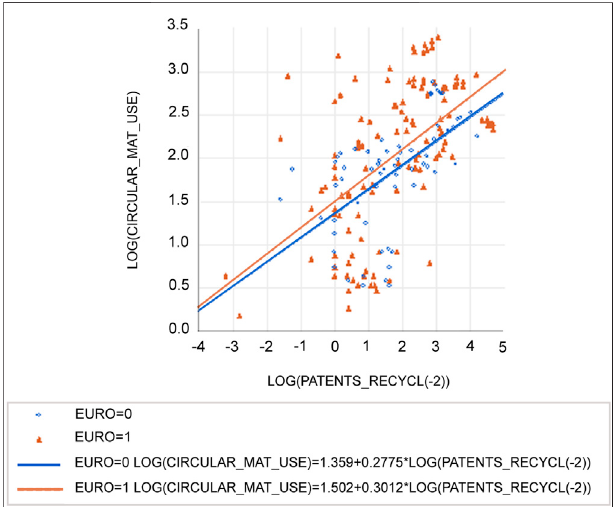
FIGURE 4 | Scatterplot of the two main variables considered and the in fl uence of dummy variable EURO/Source: own calculation with Eurostat 2020